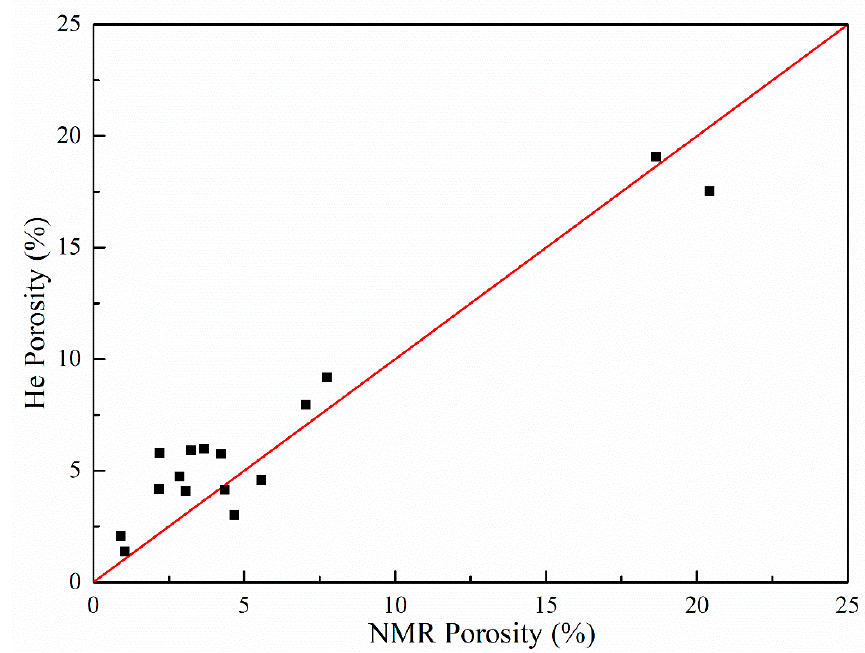
Figure 6. Nuclear magnetic porosity versus gas porosity. Table 4. Analysis of pore characteristics of experimental coal samples by Nuclear magnetic resonance (NMR).